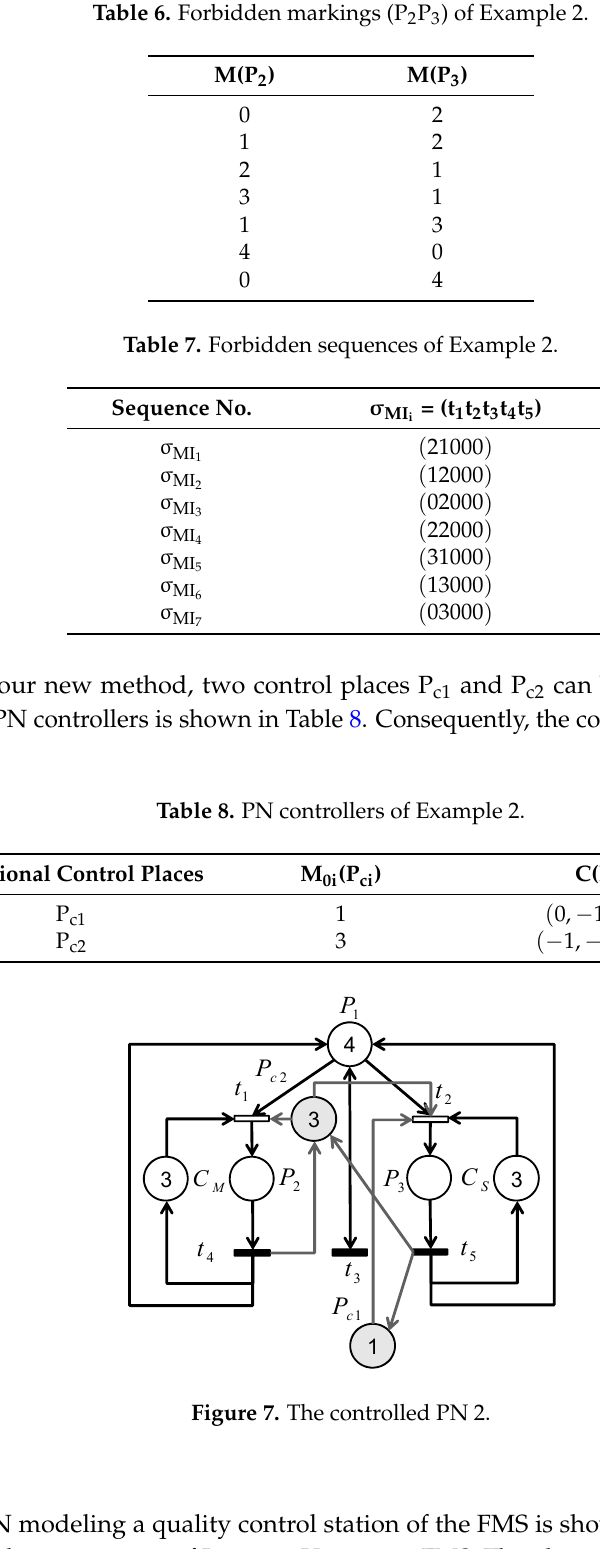
Table 7. Forbidden sequences of Example 2. Sequence No.